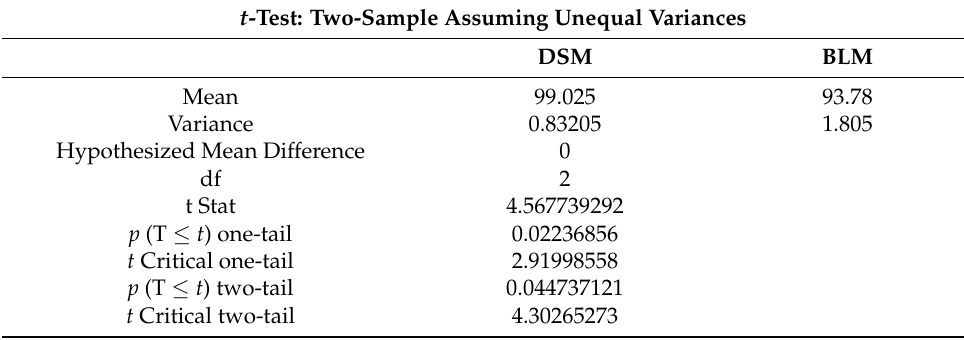
Table 7. Statistical comparison of DSM and BLM based on binary classification results. t -Test: Two-Sample Assuming Unequal Variances